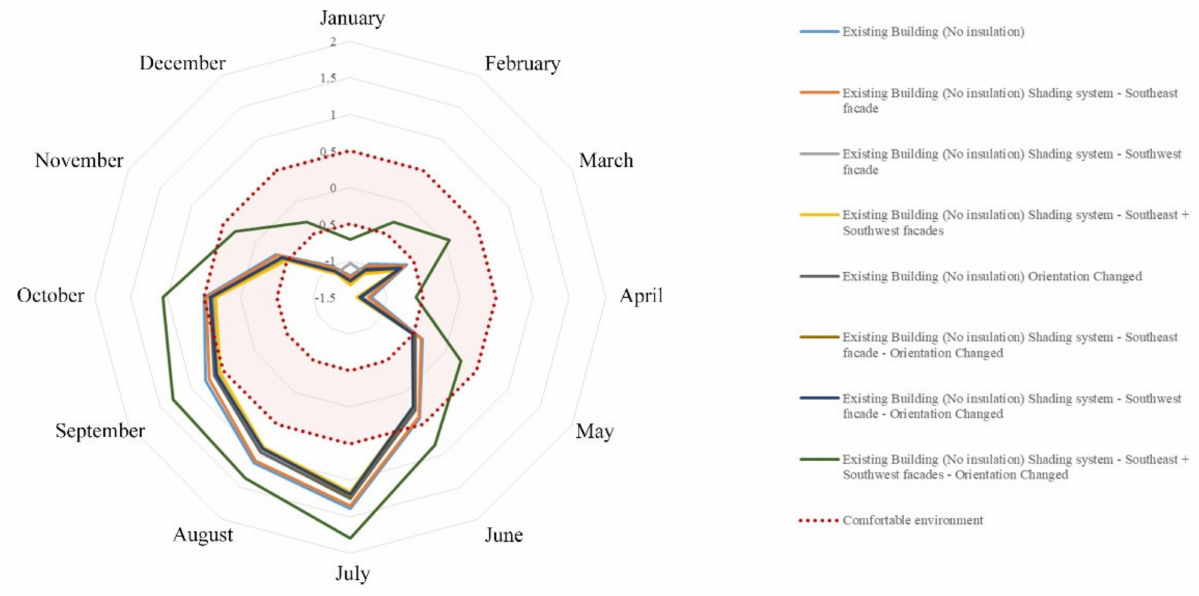
Figure 18. Monthly average calculation: predicted mean vote (PMV)—scenarios with no